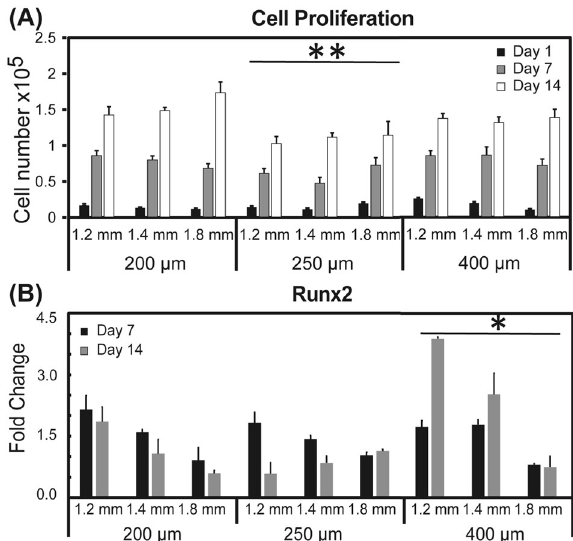
Fig. 9 A Cell proliferation of MSCs on scaffolds printed with varying inner spacings and tip diameters. All groups were signi fi cantly dif- ferent ( p < 0.001) across all time points (not shown). Scaffolds printed using a tip diameter of 250 µm yielded cell proliferation that was signi fi cantly (** p < 0.001) than scaffolds printed with the other tip diameters. B Runx2 expression of MSCs on scaffolds printed with varying inner spacing and tip diameters. Gene expression was sig- ni fi cantly different ( p < 0.05) between all inner spacings (not shown). Runx2 expression of cells seeded on scaffolds printed with a 400 µm tip diameter were signi fi cantly higher (* p < 0.05) than those scaffolds printed with other tip